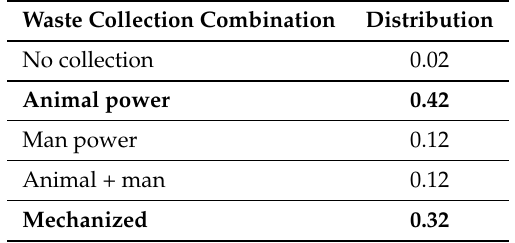
Table 7. Overall distribution of the categorical variable “waste collection combination”.